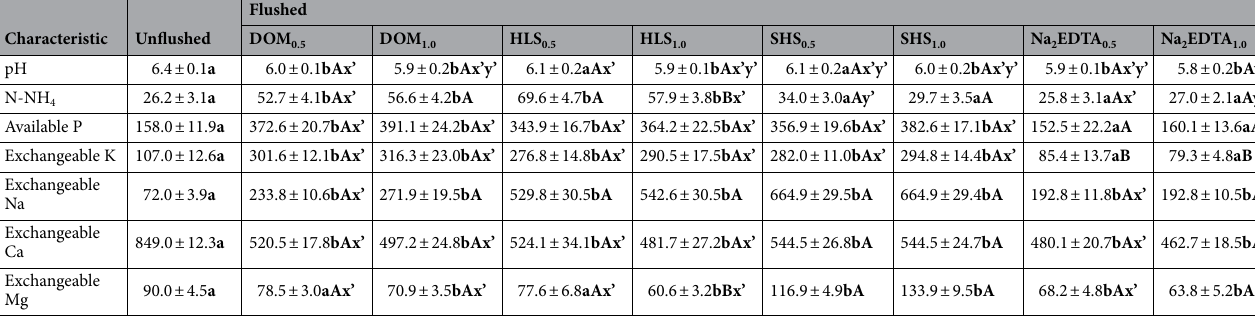
Table 2. Comparison of pH, and selected macroelement concentrations (in mg/kg) in soil before and after flushing with DOM, HLS, SHS and Na 2 EDTA (standard deviation from the mean value, n = 3). For a given nutrient, different letters indicate significant differences in nutrient content in unflushed and flushed soil (ANOVA followed by Tukey’s HSD test, p < 0.05). Small letters indicate differences in nutrient content between unflushed and flushed soil, capital letters indicate differences in nutrient content in soil flushed at different flow rates with a given WA. The sign x’ or y’ means no statistically significant differences between some treatments.